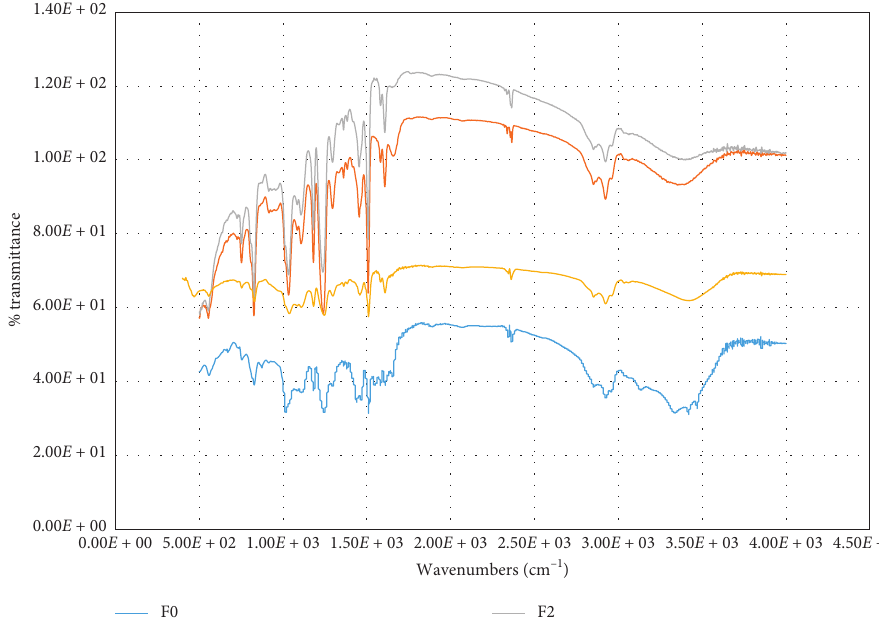
Figure 11: FTIR spectra of formulation F0, F1, F2, and F3 (F0: the coating consisted of the absence of MWCNTs, F1: 0.5 wt.% MWCNTs, F2: 1 wt.% MWCNTs and F3: 1.5 wt.%